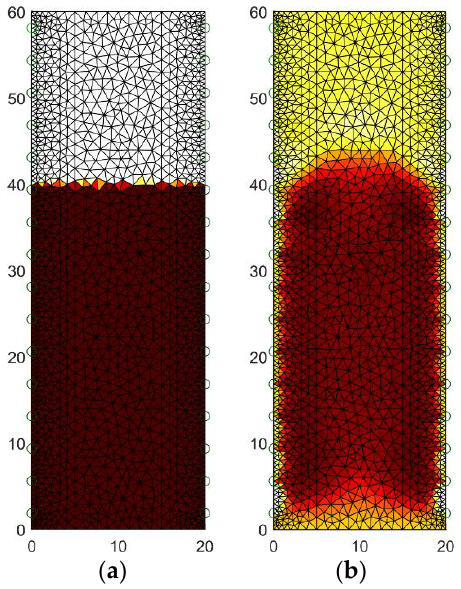
Figure 8. The geometrical model of the tested wet wall with 32 electrodes: ( a ) the pattern image, ( b ) the image reconstructed by Gauss-Newton method.